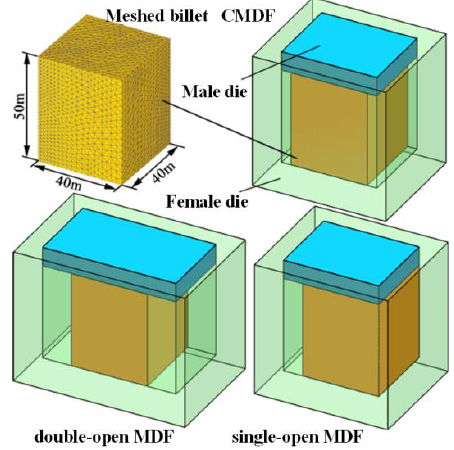
Figure 2. Finite element models.